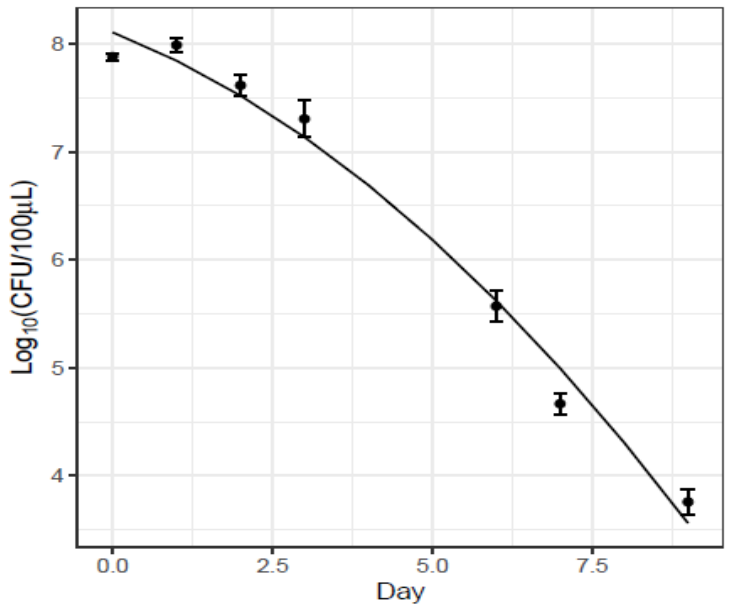
Figure 6. Quantity of Serratia detected (on erythritol plates) during 9 days from 80 mg bran inoculated with 6 × 10 9 CFU Sm culture and stored at 30 ◦ C. Mean of 3 batches SEM (standard error of the mean).